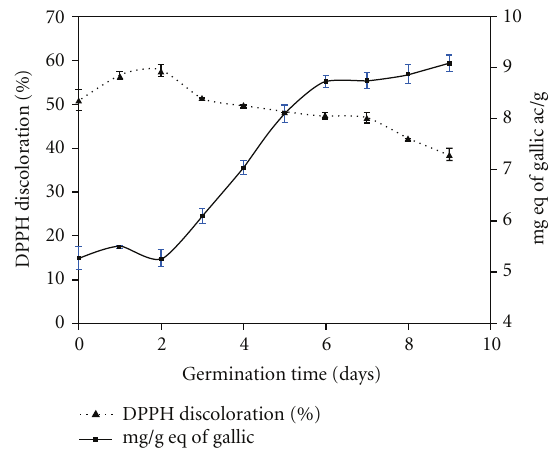
Figure 3: Phenolic compound variation and antioxidant capacity in L. campestris germinated